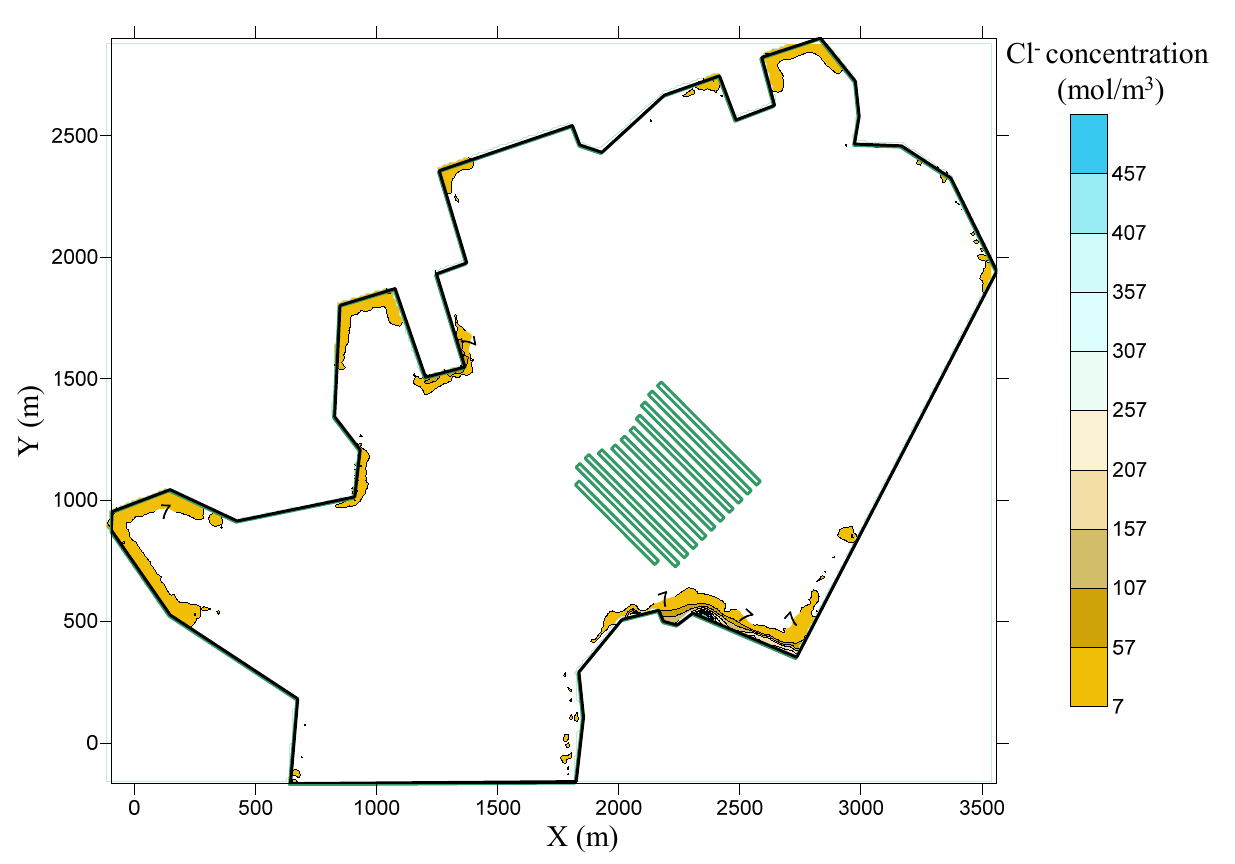
Figure 14. Cl − concentration contour map of Section 2 at the end of cavern construction.